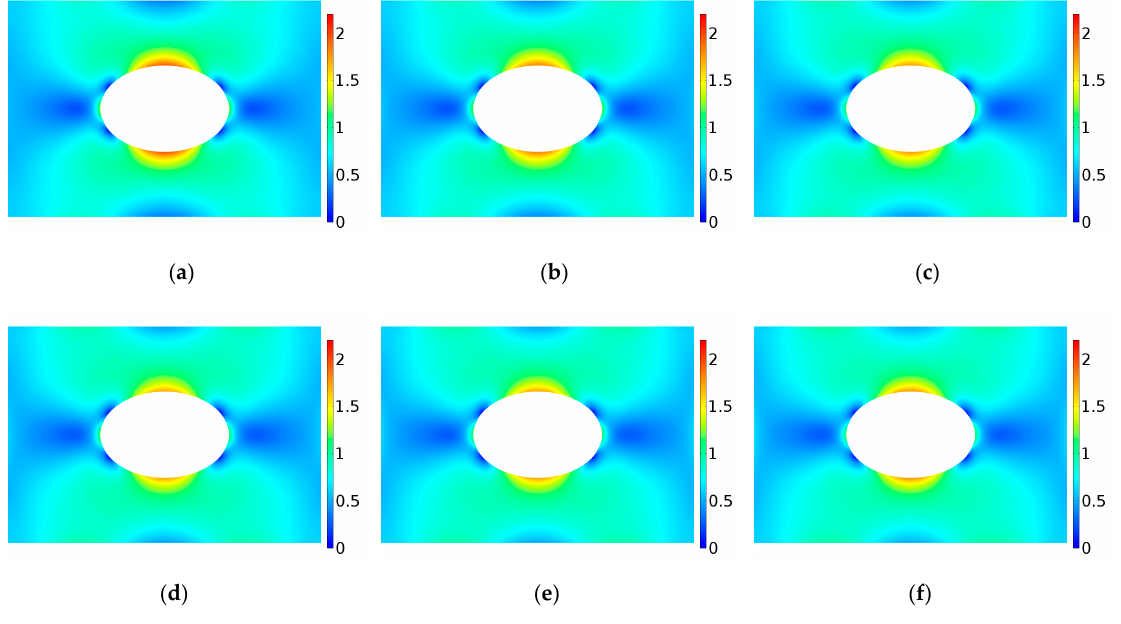
Figure 6. Variation of dimensionless Von Mises stress distribution for r-FGM when γ = 1; The power-law inhomogeneous variation when c < 0. γ = − 0.5. ( a ) γ = 1, c = 0.1; ( b ) γ = 1, c = 0.5; ( c ) γ = 1, c = 1; ( d ) γ = 1, c = 1.5; ( e ) γ = 1, c = 2.0; ( f ) γ = 1, c = 3.